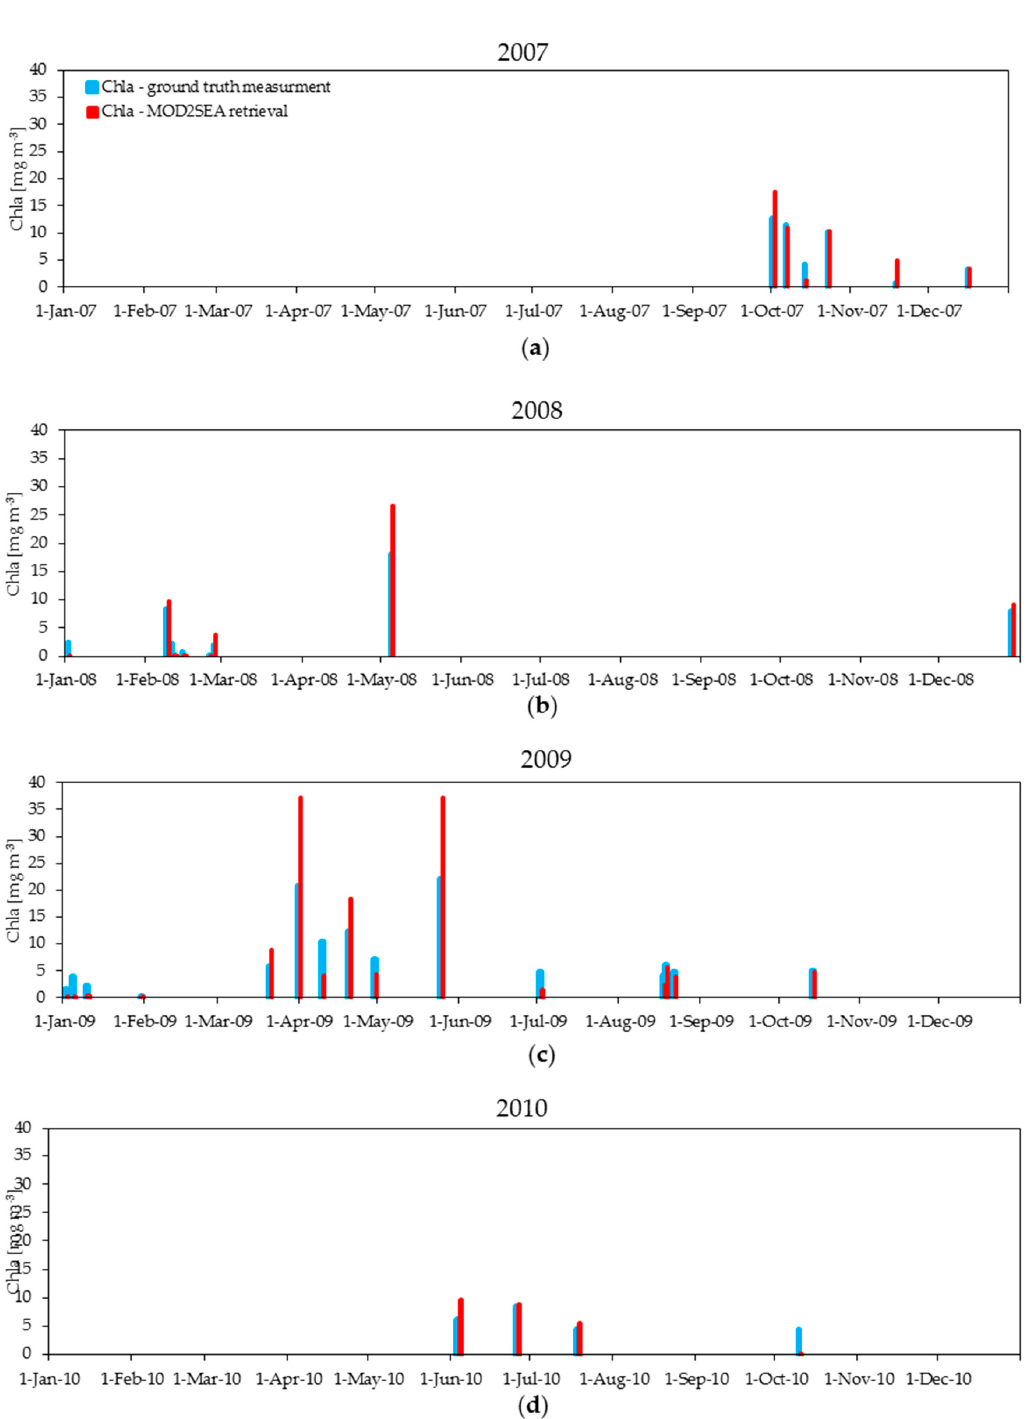
Figure 8. ( a – d ) The four-year comparison of derived Chla values using the coupled MOD2SEA model (red line) and ground truth measurements (blue line) (mg·m − 3 ) from 2007 − 2010 at matchup moments.